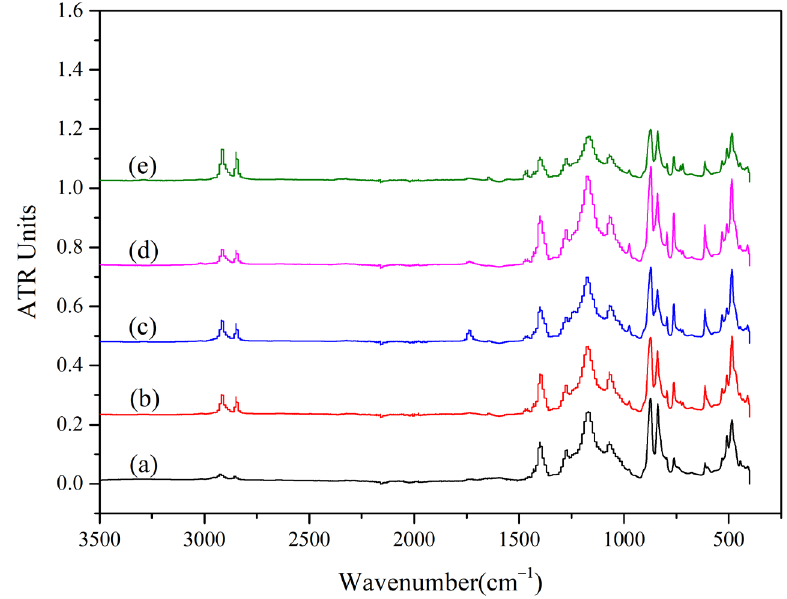
Figure 8. The FT-IR spectra of PVDF: ( a – e ) exposure time of 0, 1, 3, 5, and 7 weeks.